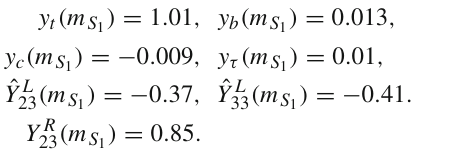
whichleadstoareductionofthematrixelement flowtowardstheIR.Thelow-energyvalueof and results inconsistent with either Eq. (27) or C S